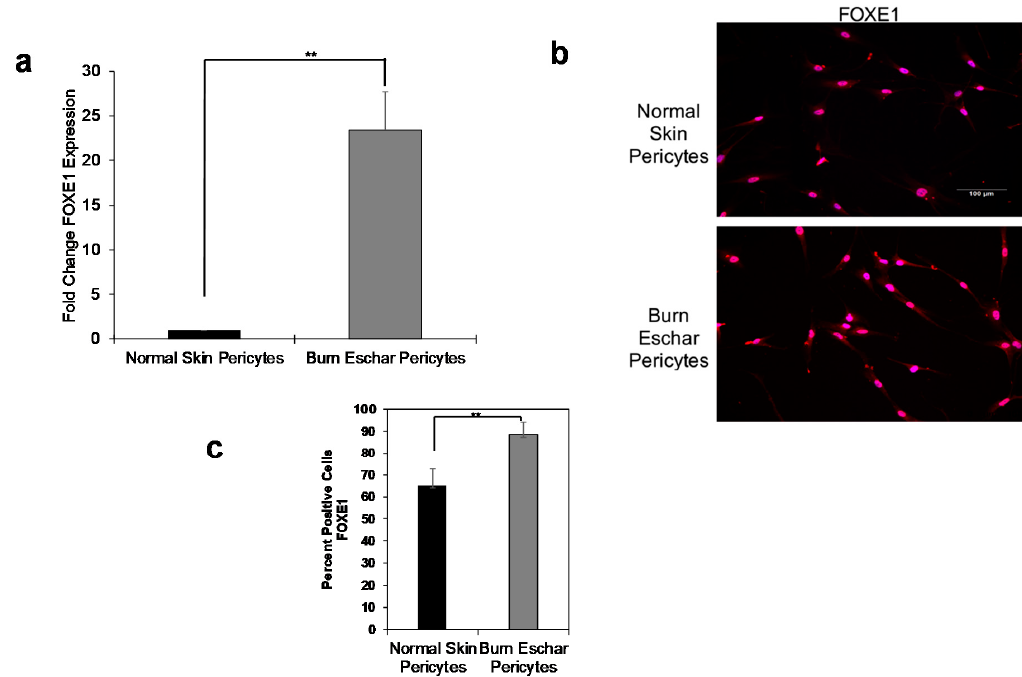
Figure 5. Pericytes express forkhead box E1 (FOXE1). ( a ) mRNA expression of FOXE1, ( b ) immunofluorescence of FOXE1 protein expression, and ( c ) Quantitative analysis of FOXE-1 protein expression. Both normal and burn eschar pericytes express FOXE1 but the burn eschar pericytes have a significantly greater expression of FOXE1 than normal pericytes. Three different cultures of pericytes derived from three different patients of normal skin and burn eschar tissues were utilized for real time RT-PCR; two different cultures of normal skin and burn eschar was used for immunofluorescence. Quantitative analysis was performed on FOXE1 stain in 3 10× high powered fields using NIS-Elements AR3.1 software. Data represented as mean ± SEM of two independent studies. Scale bar: 100 μ M. Statistical analysis was performed using Student’s t test with p < 0.05 considered statistically significant. ** p < 0.01.